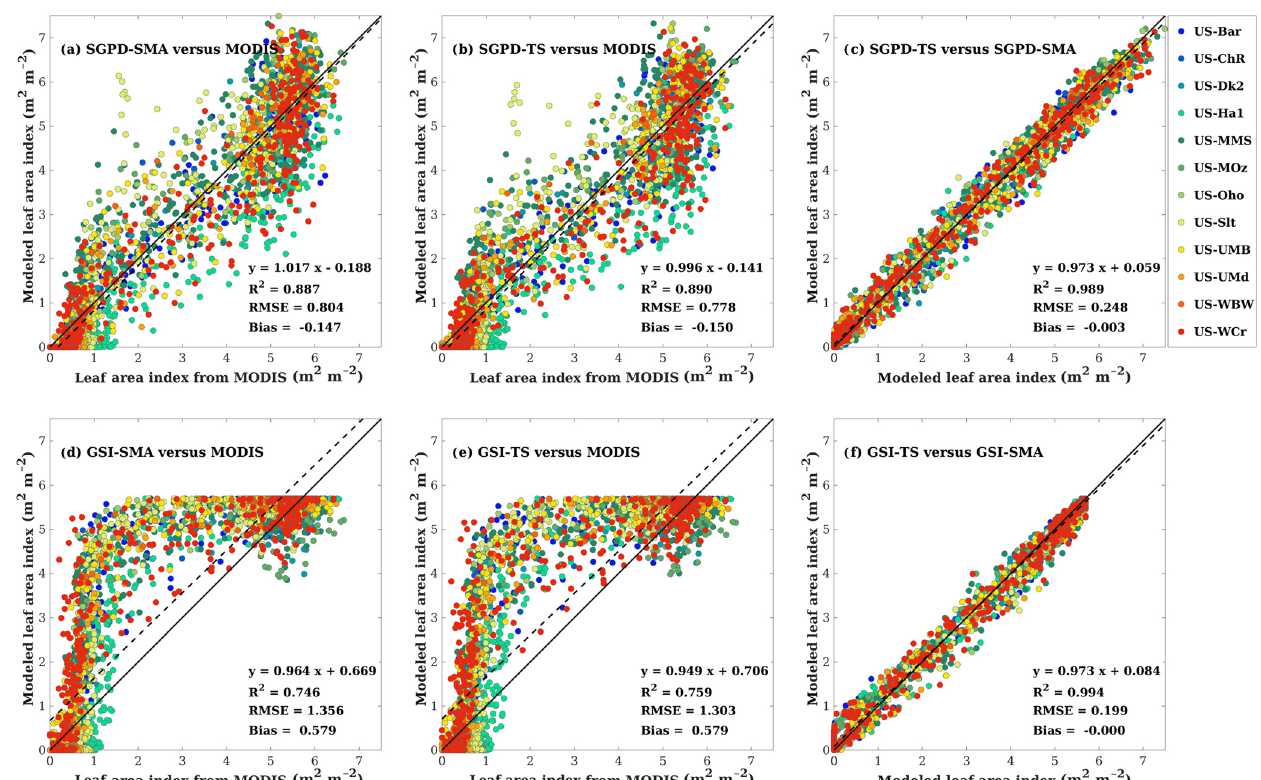
Figure 2. Scatter plots are shown for comparisons (a) between the SGPD-SMA LAI and the MODIS LAI, (b) between the SGPD-TS LAI and the MODIS LAI, (c) between the SGPD-TS LAI and the SGPD-SMA LAI, (d) between the GSI-SMA LAI and the MODIS LAI, (e) between the GSI-TS LAI and the MODIS LAI, and (f) between the GSI-TS LAI and the GSI-SMA LAI on a weekly basis. All available site-year flux tower data were included in the analysis. The solid lines denote the 1:1 lines and the dashed lines denote the regression lines. Table 2. The performance of the modeled timings of phenophases as evaluated against satellite observations. The timings of phenophases were derived based on the dates at which the leaf area index reaches 20%, 50%, and 80% of seasonal amplitude. Positive mean bias error (MBE) indicates that the modeled spring onsets are earlier than the observed ones and negative MBE indicates the opposite.